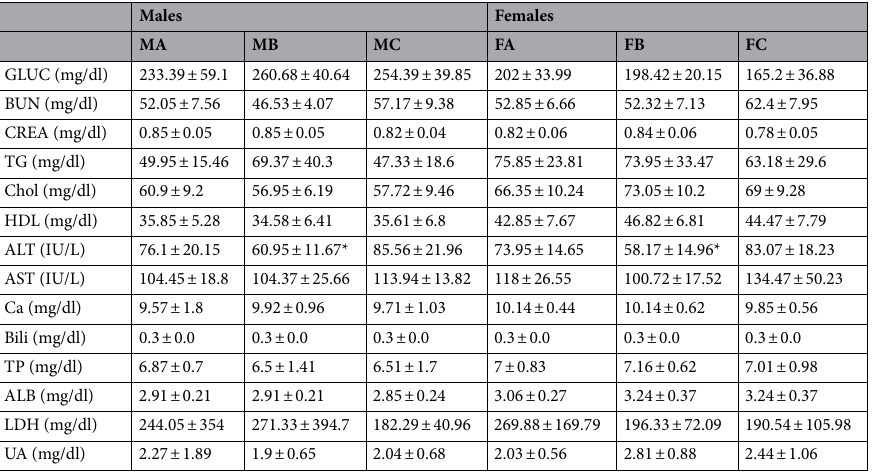
Table 2. Serum biochemical parameters in the studied groups on the 90th day. Each value is presented as mean ± SD. MA: male rats with Tarom molaii rice feeding, MB: male rats with GM Bt rice feeding, MC: male rats with standard feeding, FA: female rats with Tarom molaii rice feeding, FB: female rats with GM Bt rice feeding, FC: female rats with standard feeding. Gluc: glucose , BUN: blood urea nitrogen, CREA: creatinine, TG: triglyceride, Chol: cholesterol, HDL: high density lipoproteins, ALT: alanine aminotransferase, AST: aspartate aminotransferase, Ca: calcium, Bili: bilirubin, TP: total protein, ALB: albumin, LDH: lactate dehydrogenase, and UA: uric acid. No significant differences was observed in all groups but the ALT with the p value < 0.05.